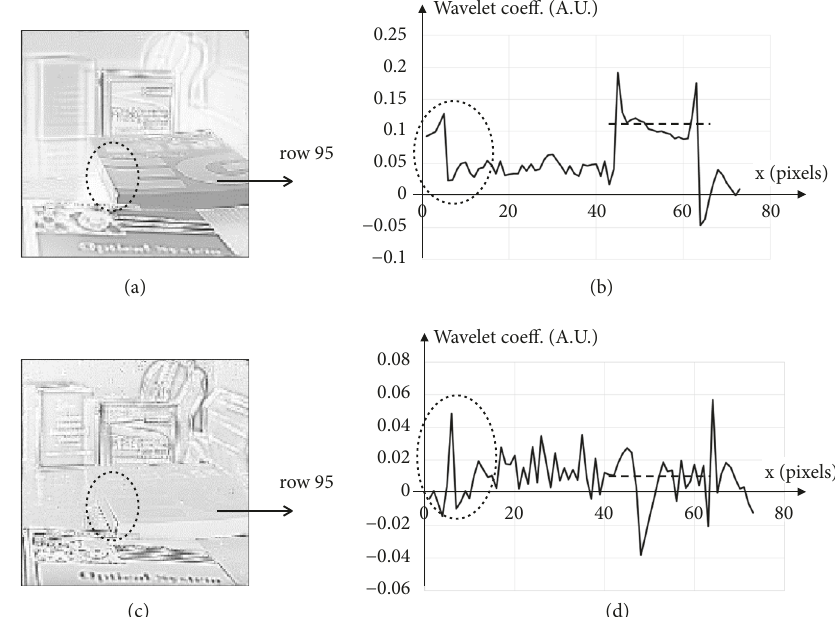
Figure 9: Wavelet coefficients (modules on the left, graph along the row 95 on the right) of source (top) and normalized (bottom) images. The layout is the same as in Figure 7.